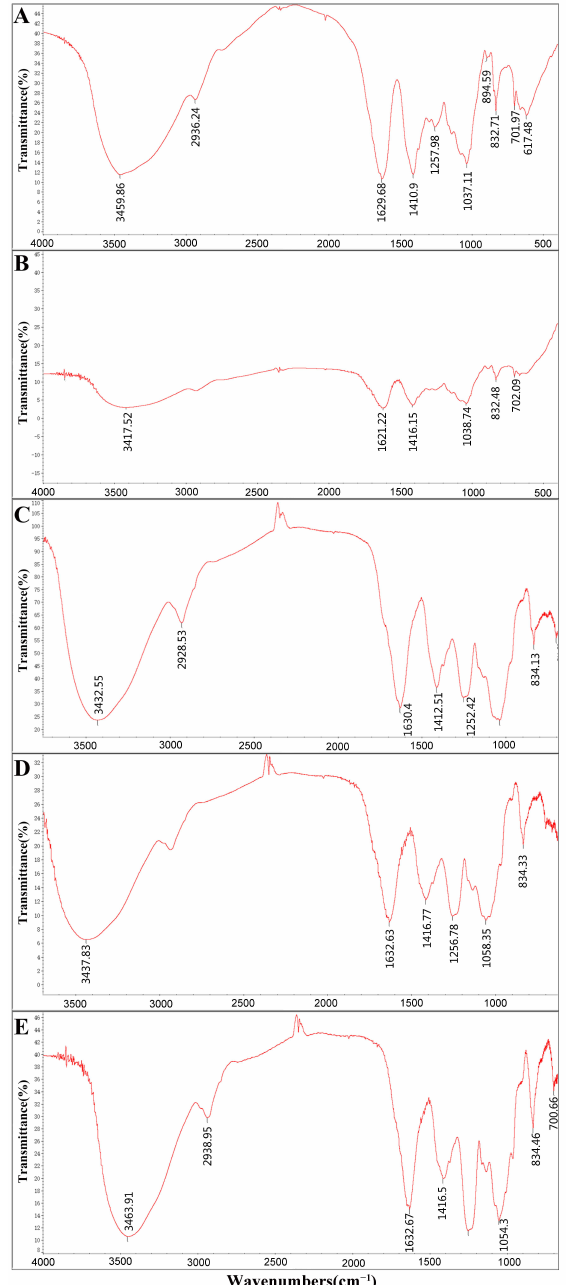
400 µ g/mL SPP-0.7 had the strongest stimulatory effect, with a cell proliferation level of 159.43 ± 7.14%.